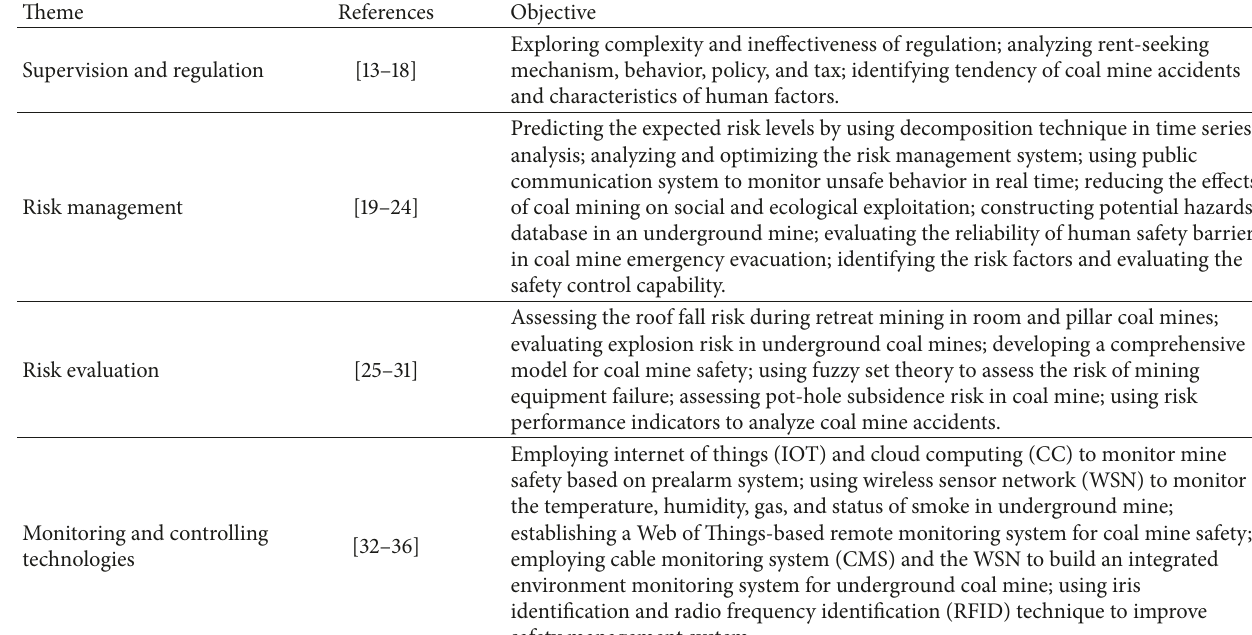
Table 1: Summary of previous study in coal